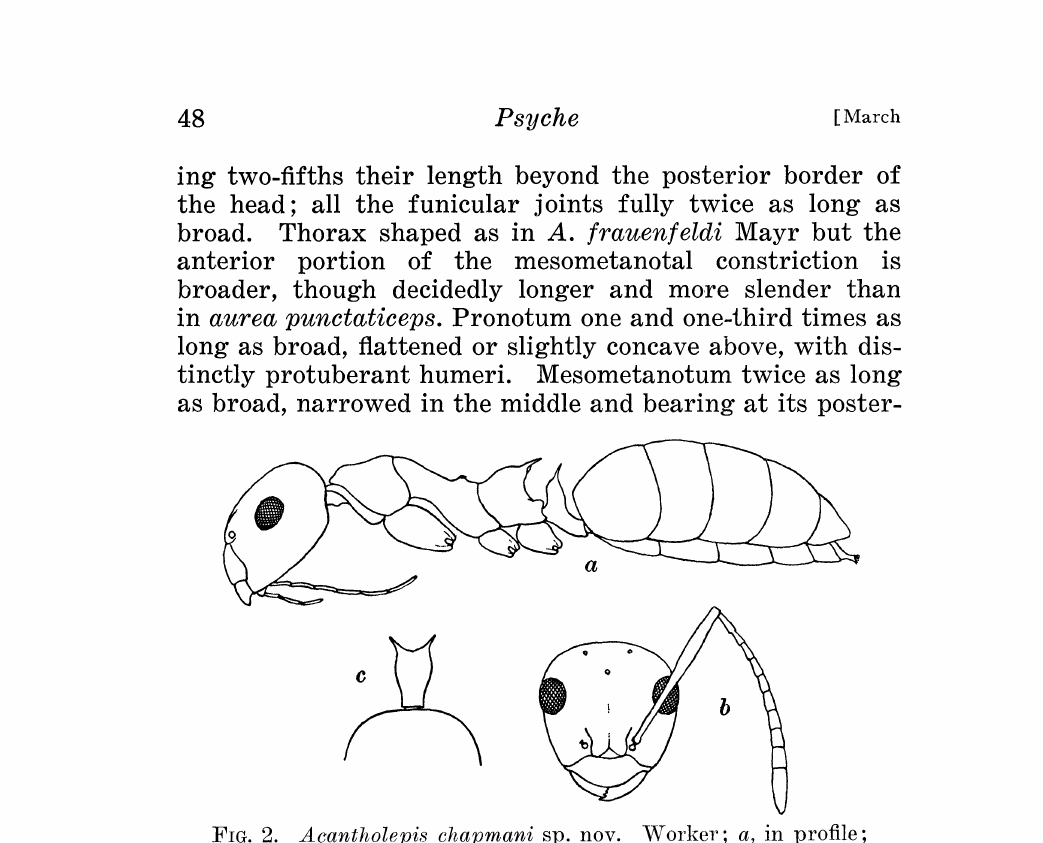
FIG. 2. Acantholepis chapmani sp. nov. Worker; a, in profile; b, head, dorsal view; c, petiole, posterior view. ior fourth the dorsally projecting spiracles which are sep- arated by a space four times their diameter.